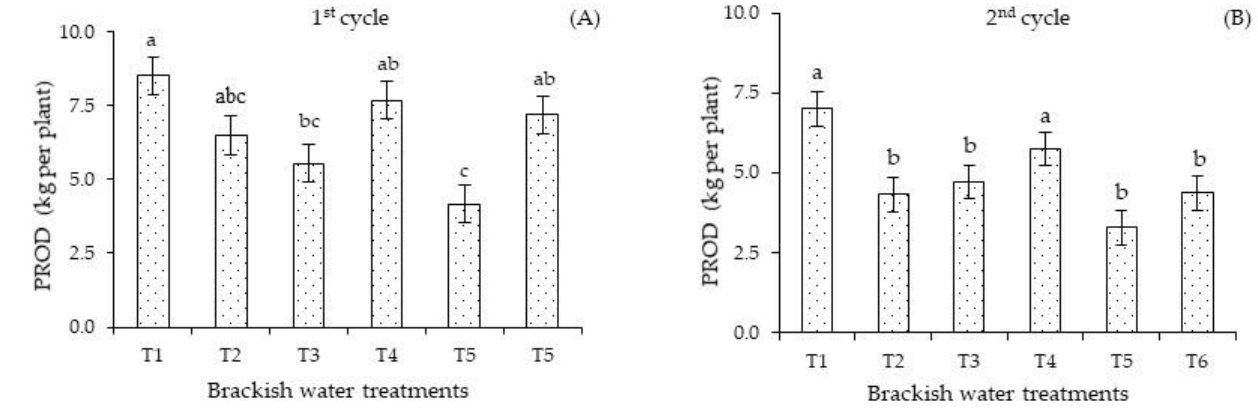
Figure 6. Production per plant—PROD of Passiflora edulis Sims as a function of salt stress, varying the phenological stages in the first ( A ) and second ( B ) cycles. Standard error of the mean ( n = 8); Means followed by different letters indicate a significant difference between treatments. T1—irrigation with low-salinity water during the entire cultivation cycle; salt stress in the following stages: T2—vegetative; T3—flowering; T4—fruiting; T5—vegetative and flowering; T6—vegetative and